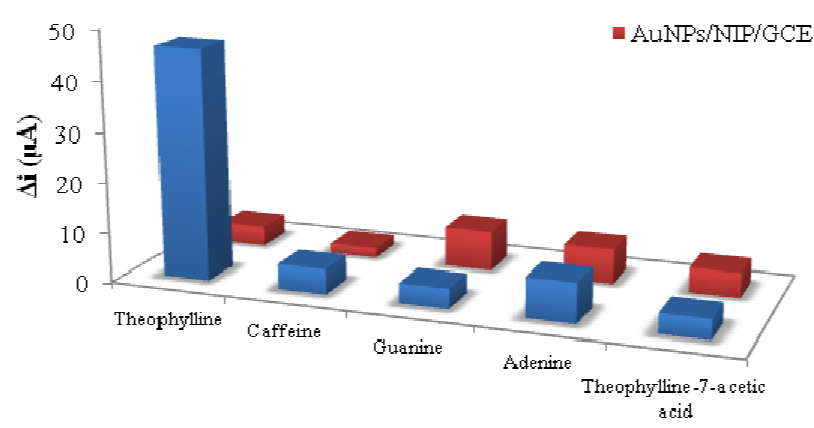
Figure 3. Selectivity comparison of Au-NPs/MIP/GCE (glassy carbon electrode), adopted from [59]. Use parenthesis for